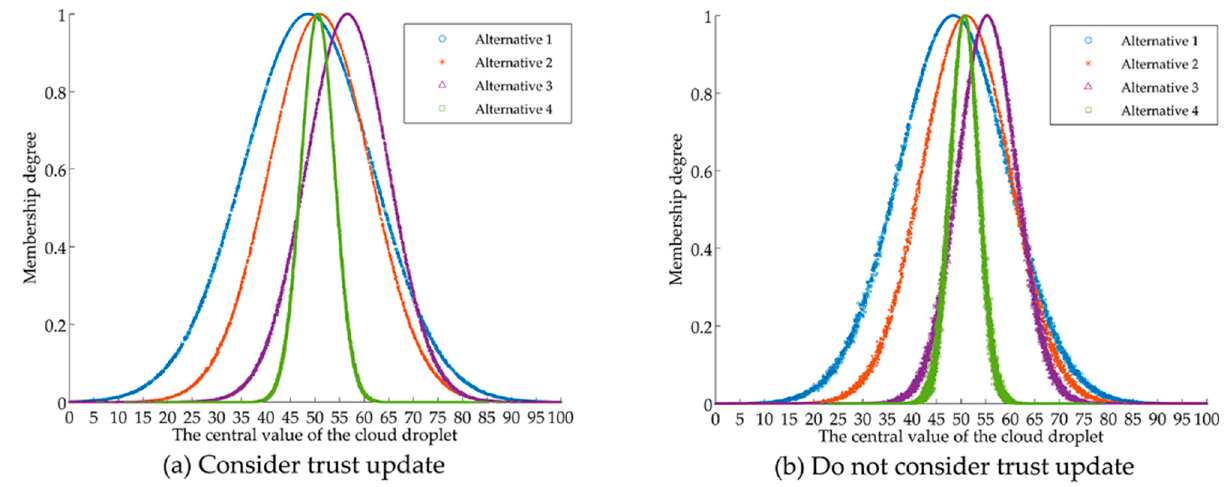
Figure 8. Integrated cloud of alternatives after reaching a consensus.